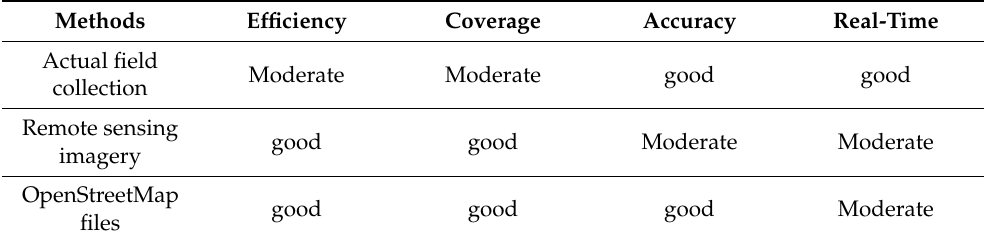
Table 4. A comparison of different road extraction methods.